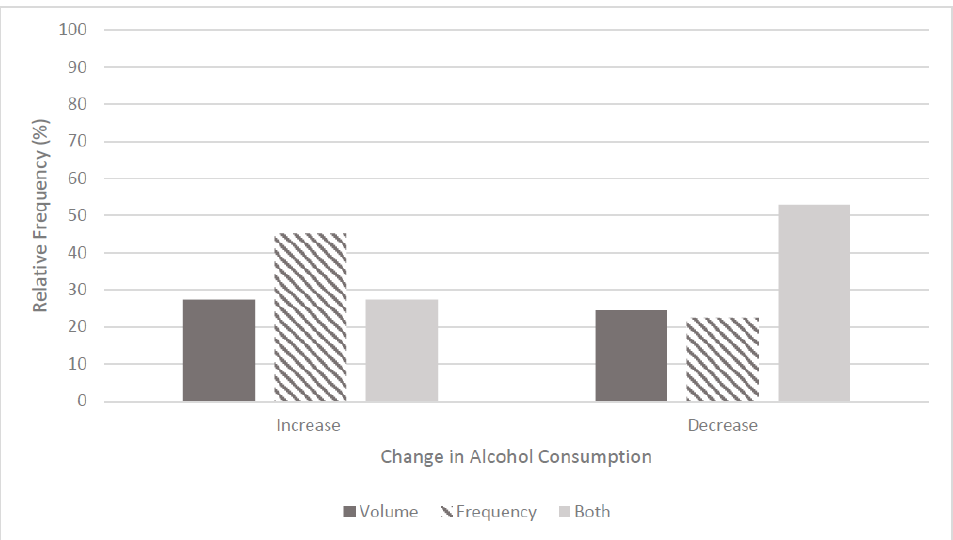
Figure 3. Self-reported changes in participants’ volume and/or frequency of alcohol